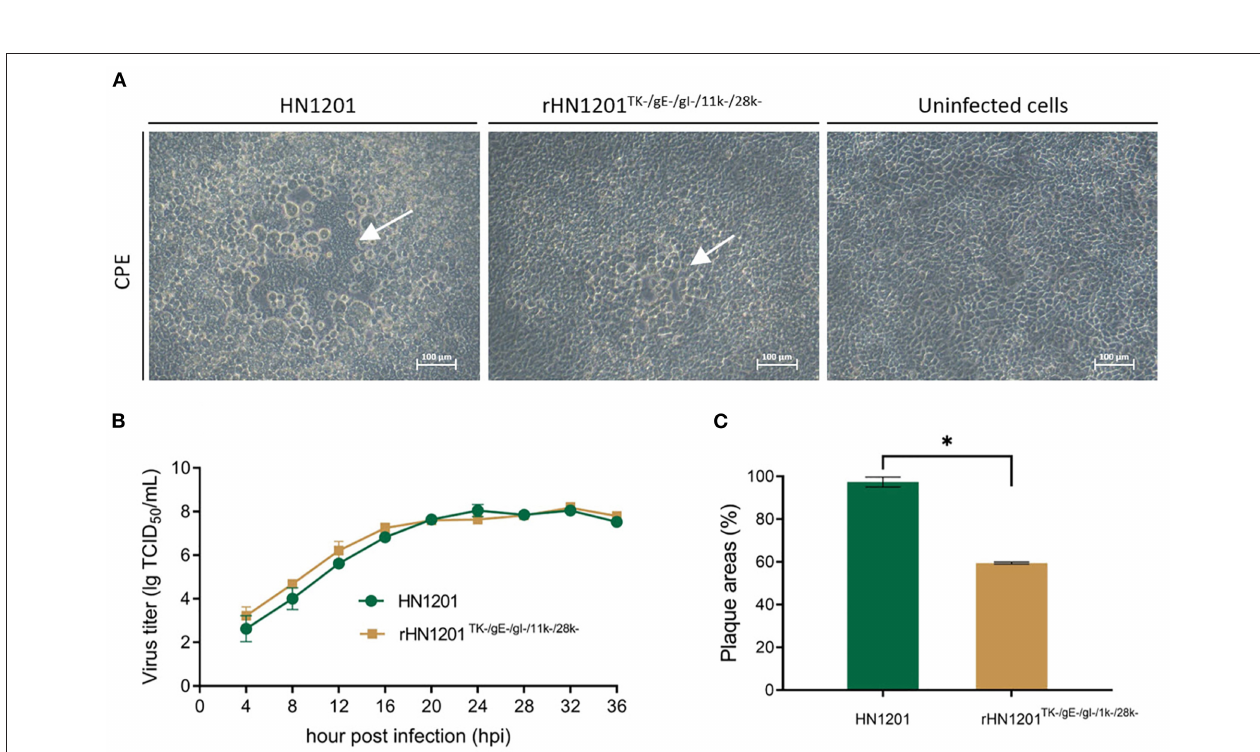
FIGURE 2 | Rescue and the characterization of recombinant PRV. (A) Cytopathic effect in Vero cells after transfection with recombinant PRV pBAC plasmids. The white arrow indicated the CPE. Bar = 100 µ m. (B) Multiple growth curves of the chimeric viruses. The culture supernatants were collected at the indicated time points for the viral titer determination. (C) Plaque size of the recombinant viruses. The plaques were measured at 48 hpi. The plaque size induced by the parental virus was set at 100%. Asterisk denotes a statistically significant difference ( p < 0.05).